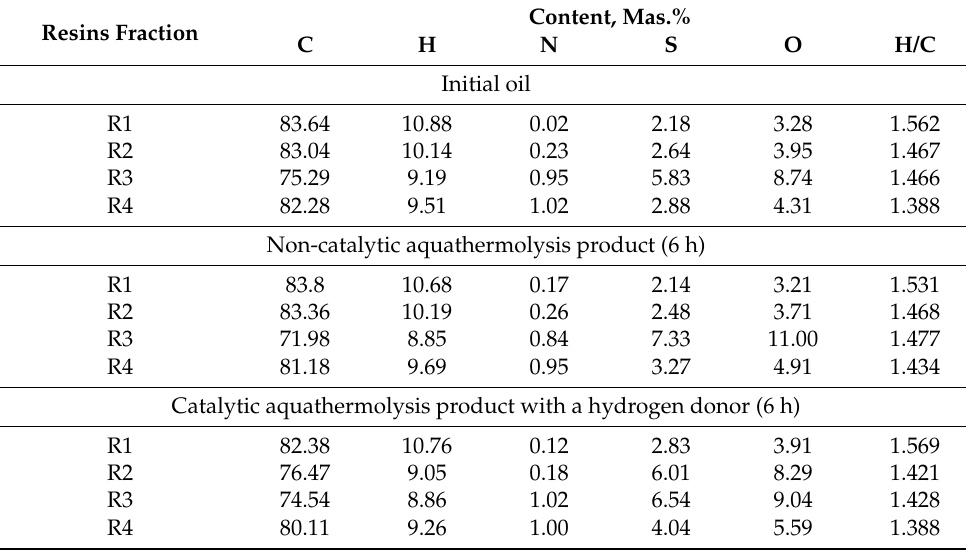
Table 1. Elemental composition of resins